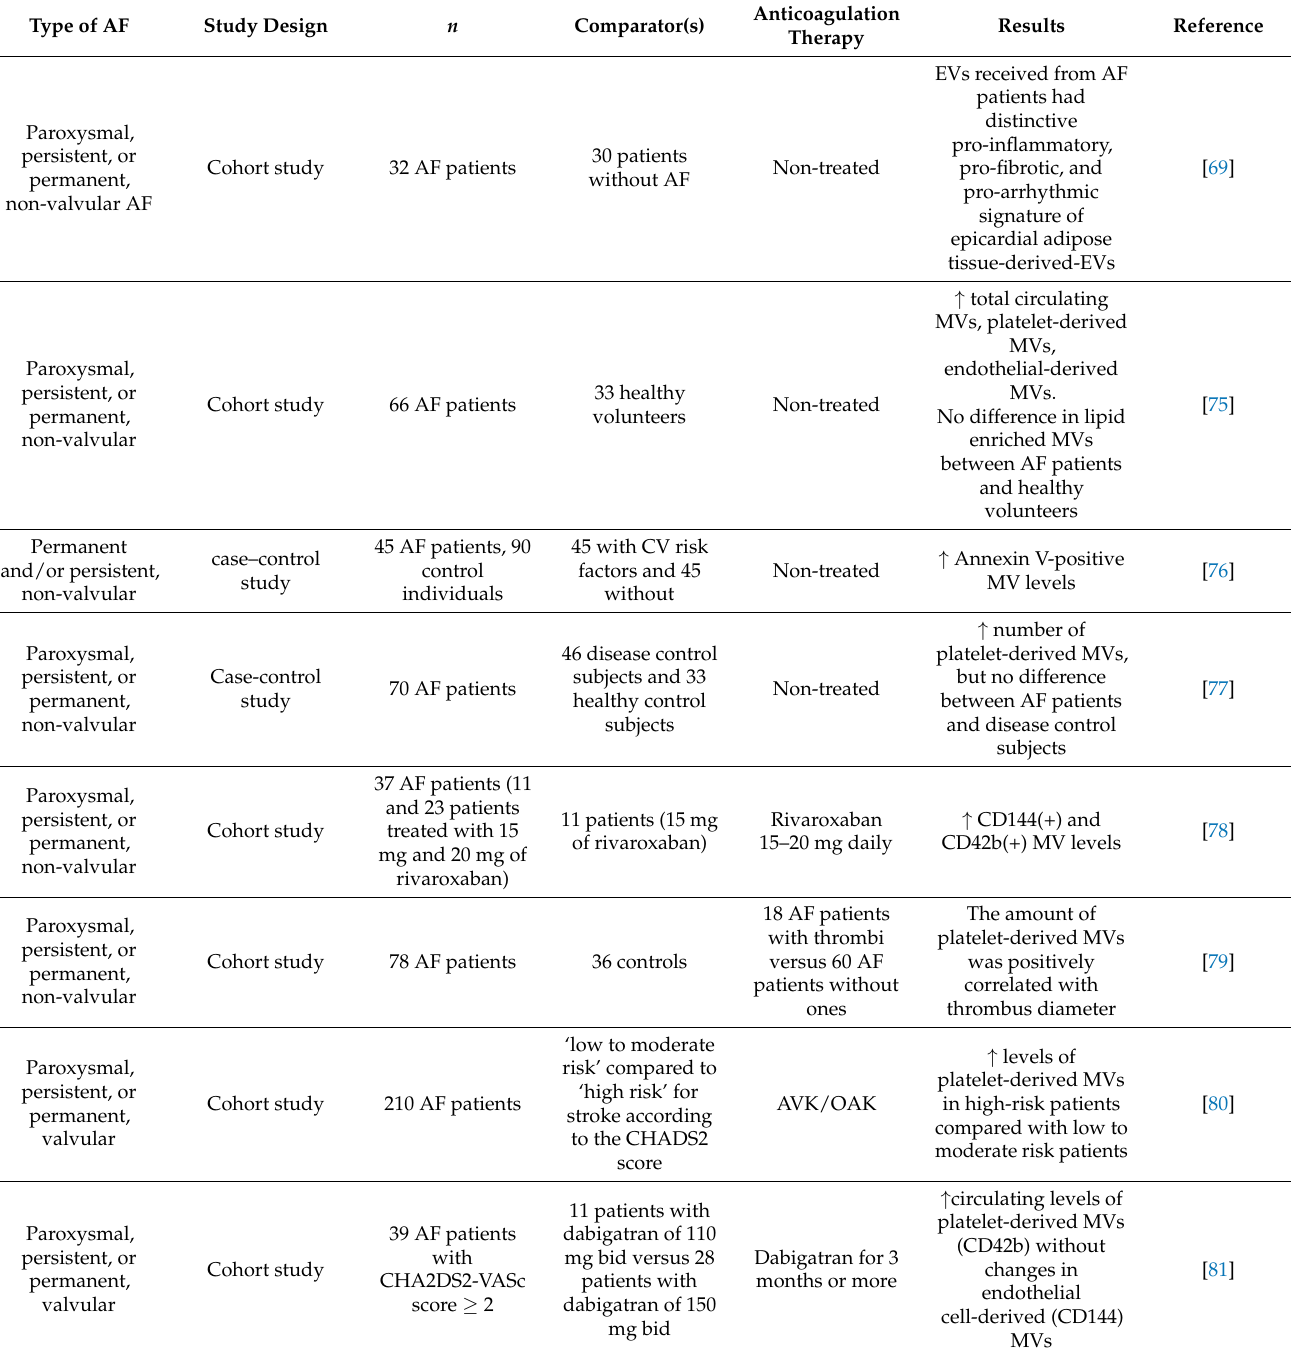
Table 2. The signature of EVs in patients with non-valvular